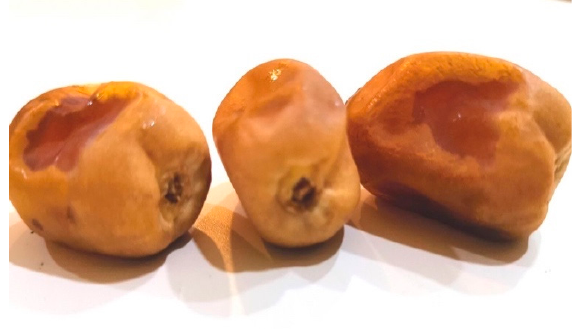
Figure 24. Sample of Al-asylaa dates.